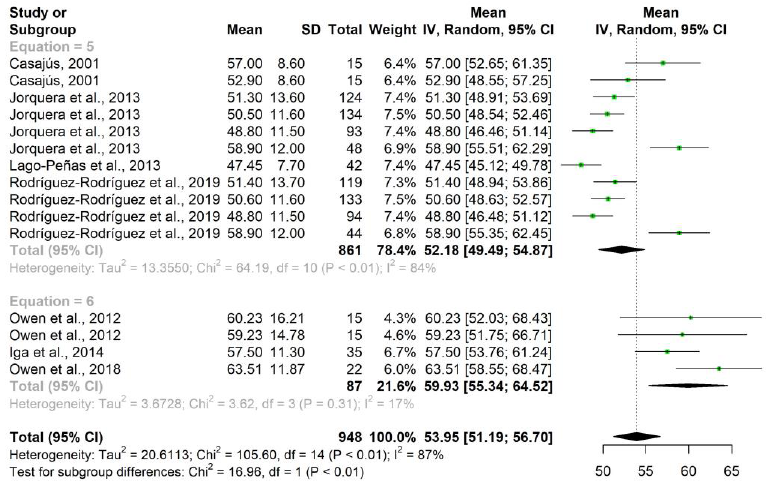
Figure 3. Forest plot sum of folds according to equation.